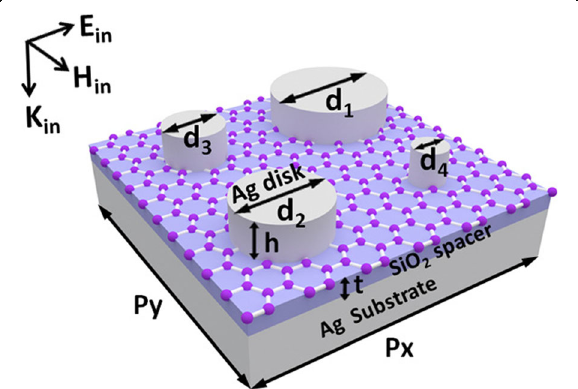
Fig. 1 Schematic of metamaterials for multiband and broadband absorption enhancement of graphene at optical frequencies, which are composed of a graphene monolayer sandwiched between four Ag nanodisks and a SiO 2 spacer on an Ag substrate. Geometrical parameters p x and p y are the array periods along the x and y directions, respectively; t is the thickness of the SiO 2 spacer; d 1 , d 2 , d 3 , and d 4 are the diameters of four Ag nanodisks ( d 1 > d 2 > d 3 > d 4 ); h is the height of the Ag nanodisks. E in , H in , and K in are the electric field, magnetic field, and wave vector of the incident light, which are along the x , y , and z axes,